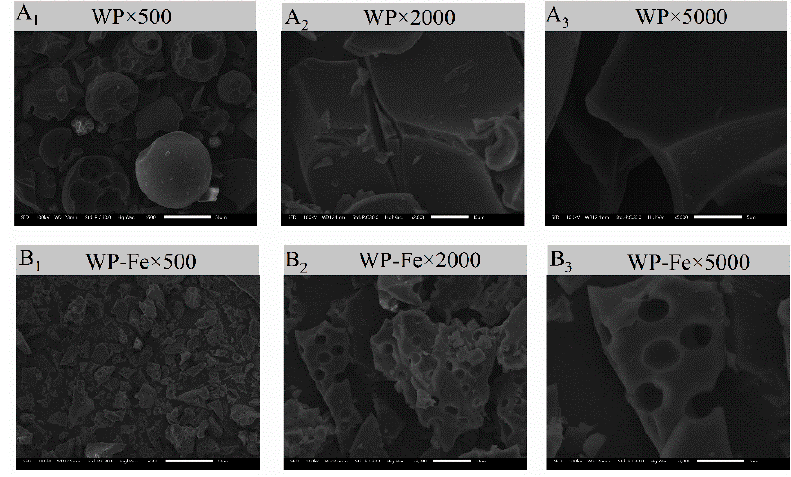
Figure 3. Microstructure of the WP ( A ) and WP-Fe chelate ( B ) determined by SEM.